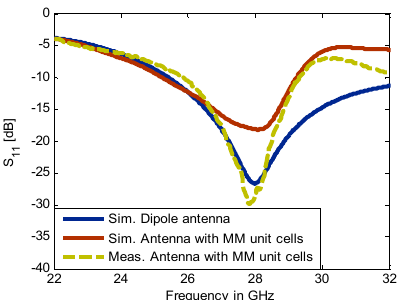
Figure 16. The simulated and measured reflection coefficient of the dipole antenna and MM antenna during the negative deflection.